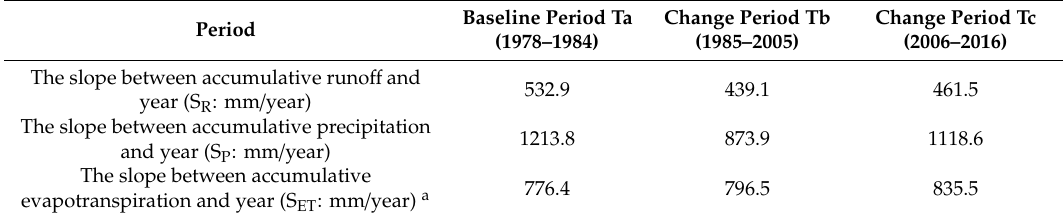
Table 4. Extracted slopes from the relationships between accumulative quantities and year in di ff erent periods.